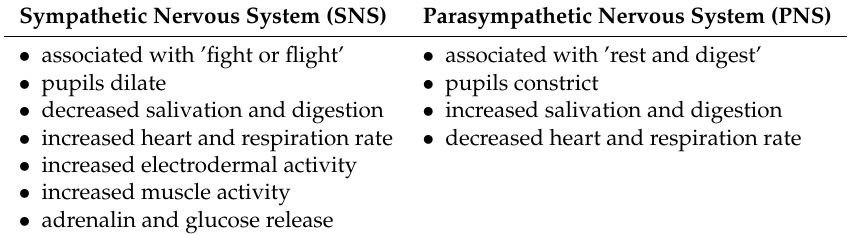
Table 1. Major functions of the sympathetic nervous system and parasympathetic nervous